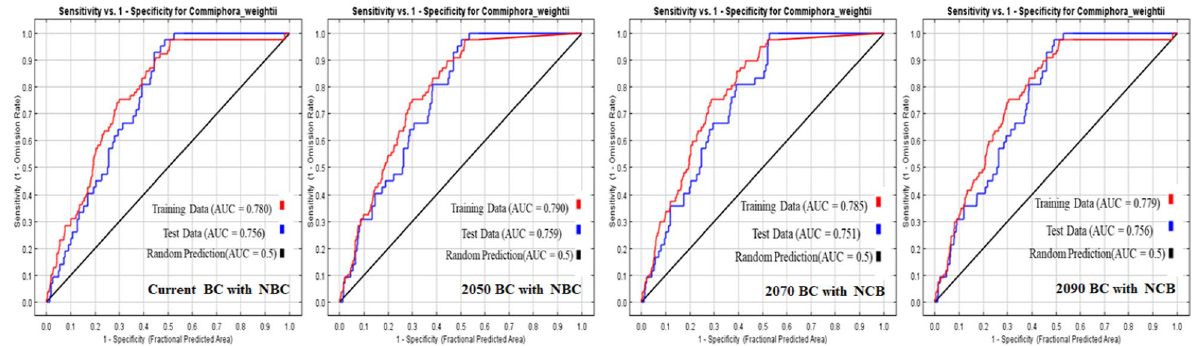
Fig. 3 Area under receiver operating characteristics curve (AUC) graphs for model performance (both training and test data set) belongs to combination of bioclimatic and non-bioclimatic variables (soil, habitat heterogeneity indices, slope and aspects and land